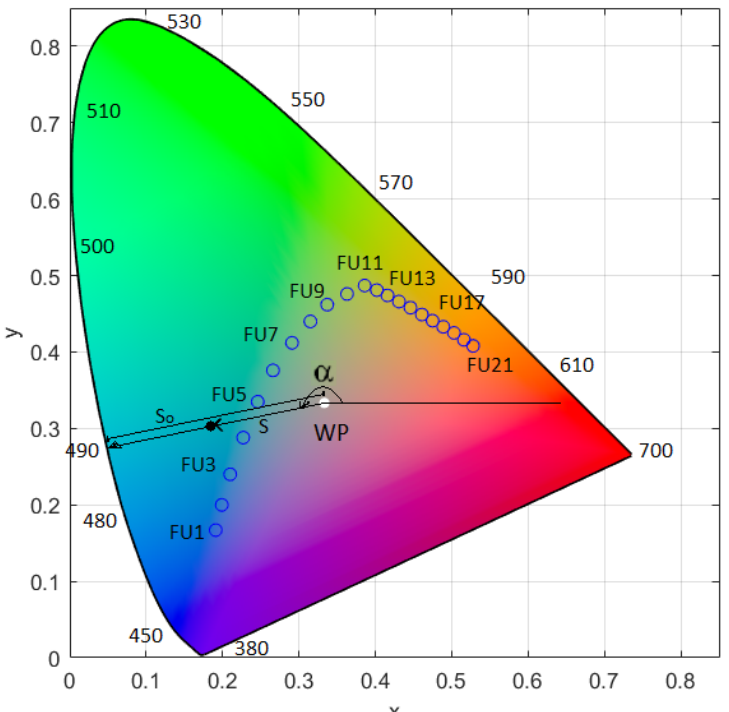
Figure 1. Chromaticity Diagram showing location of white point (WP), 21 FUI (blue circles), hue angle ( α ), and dominant wavelengths (on the locus of diagram). S and S o denote the distances from WP. The axes of diagram represent the chromaticity